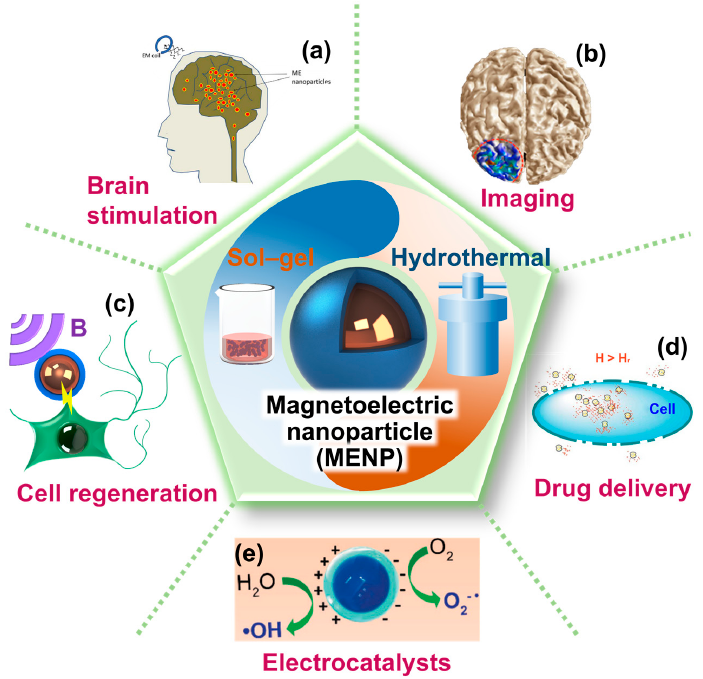
Figure 1. Schematic summary showing the synthesis methods of magnetoelectric nanoparticles (MENPs), such as sol–gel and hydrothermal, and their various biomedical and environmental applications. ( a ) Brain stimulation. Reproduced with permission from [49]. Copyright 2012, PLoS ONE. ( b ) Brain imaging. Reproduced with permission from [50]. Copyright 2018, BMC Springer Nature. ( c ) Cell regeneration. Reproduced with permission from [45]. Copyright 2022, Royal Society of Chemistry. ( d ) Drug delivery that induces nano electroporation. Reproduced with permission from [51]. Copyright 2013, Nature. ( e ) Electrocatalysts for water purification. Reproduced with permission from [48]. Copyright 2019,